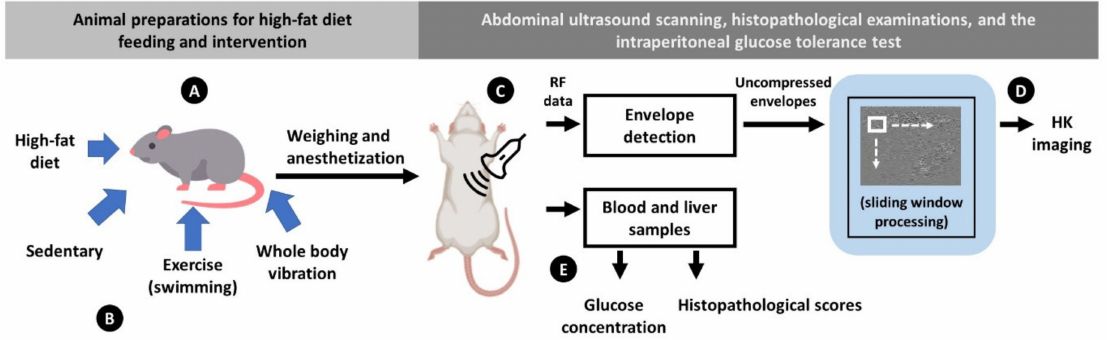
Figure 1. Illustration of the experimental design, including ( A ) animal preparation; ( B ) interventions; ( C ) ultrasound data analysis; ( D ) ultrasound backscattering analysis; ( E ) MetS evaluations and histopathological